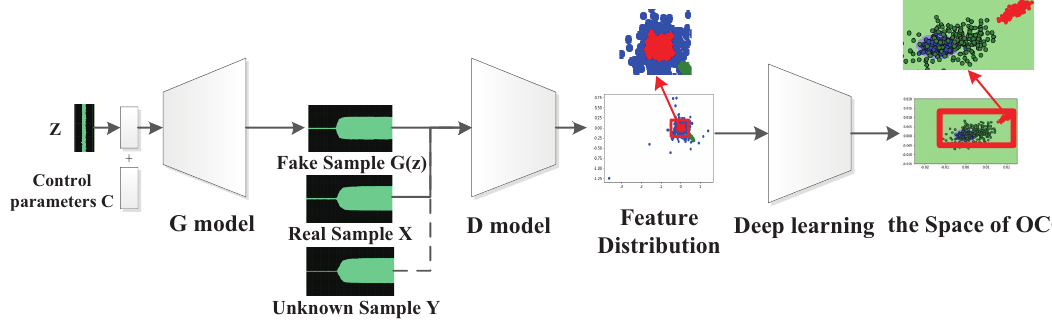
Figure 3. Framework of the OCC-GAN.